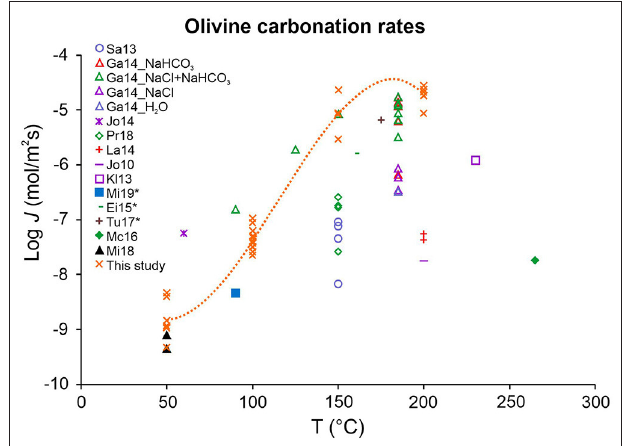
FIGURE 8 | Comparison of calculated fluxes (log J , mol/m 2 s) obtained in this study with data from the literature. Symbols are color coded based on the chemical composition of the aqueous phase: blue, distilled water; red, NaHCO 3 aqueous solution; green, NaCl + NaHCO 3 aqueous solution; purple, NaCl aqueous solution; orange, our experiments with seawater-like composition; black/brown, other. The dotted line is provided to guide the eye but is not the result of kinetic modeling. Data plotted here are listed in Table 4 .